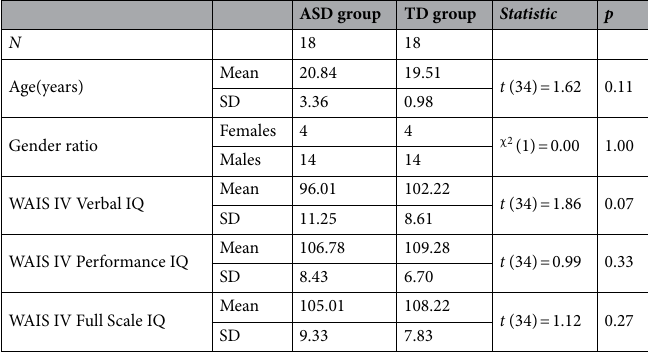
Table 1. Participant characteristics for ASD and TD groups.